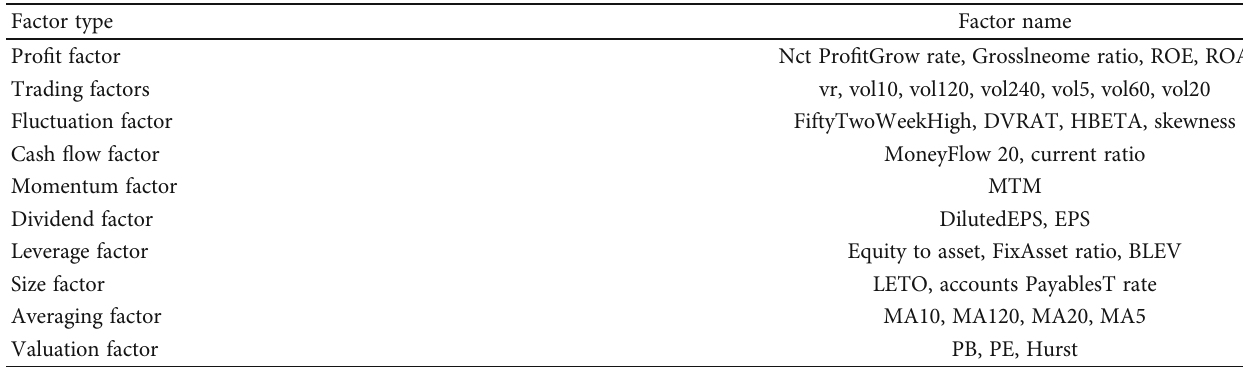
Table 3: Results of the study factor